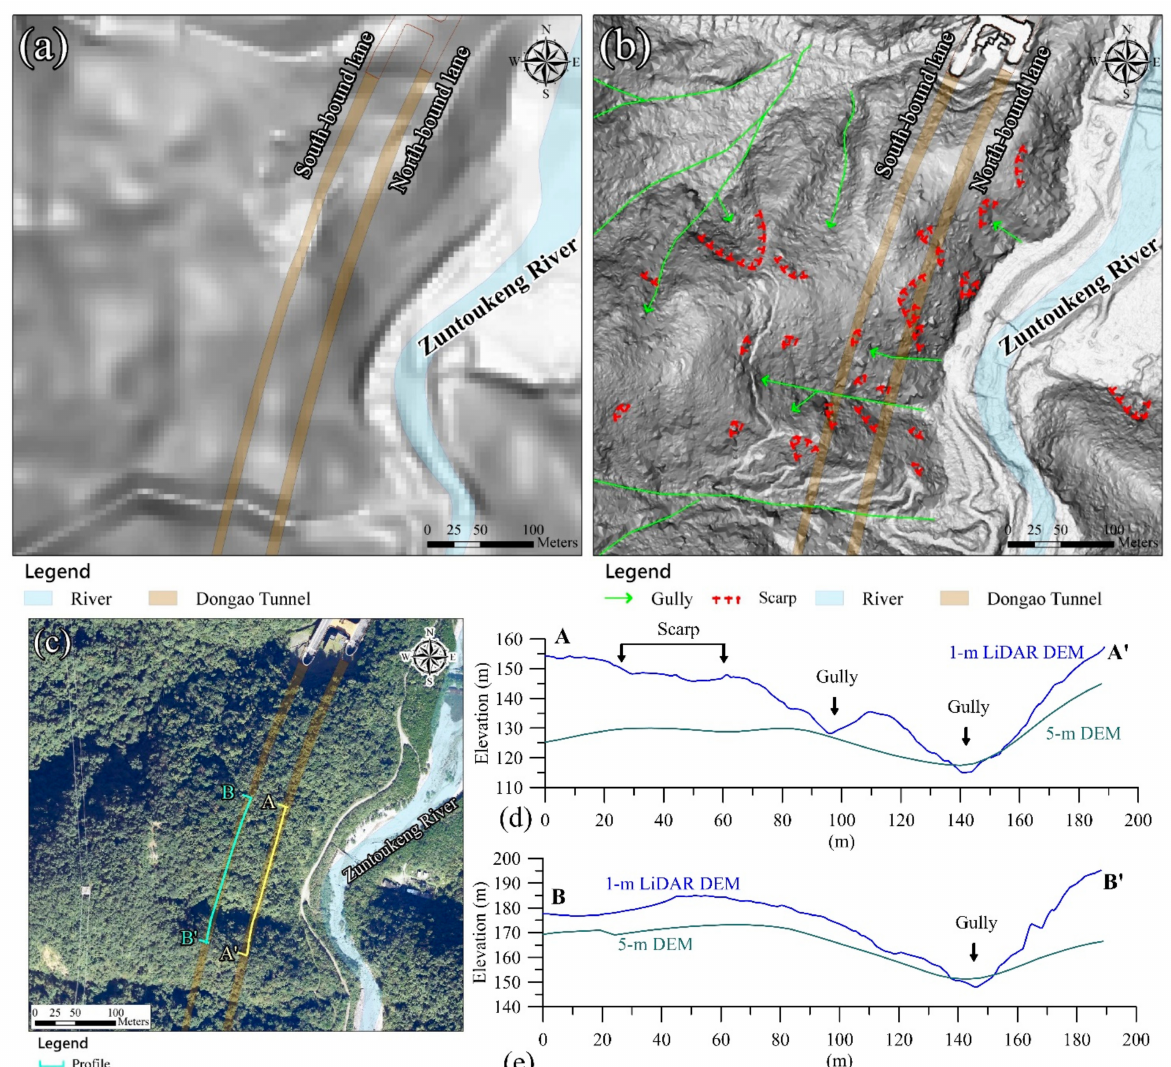
Figure 8. Clinometric maps with 5 m- ( a ) and 1 m- ( b ) resolution, and an orthoimage ( c ) near north portal of the Dongao Tunnel. Topographic profiles along the north-bound ( d ) and south-bound ( e ) lanes of the tunnel, extracted from the 1 m-resolution DEM.